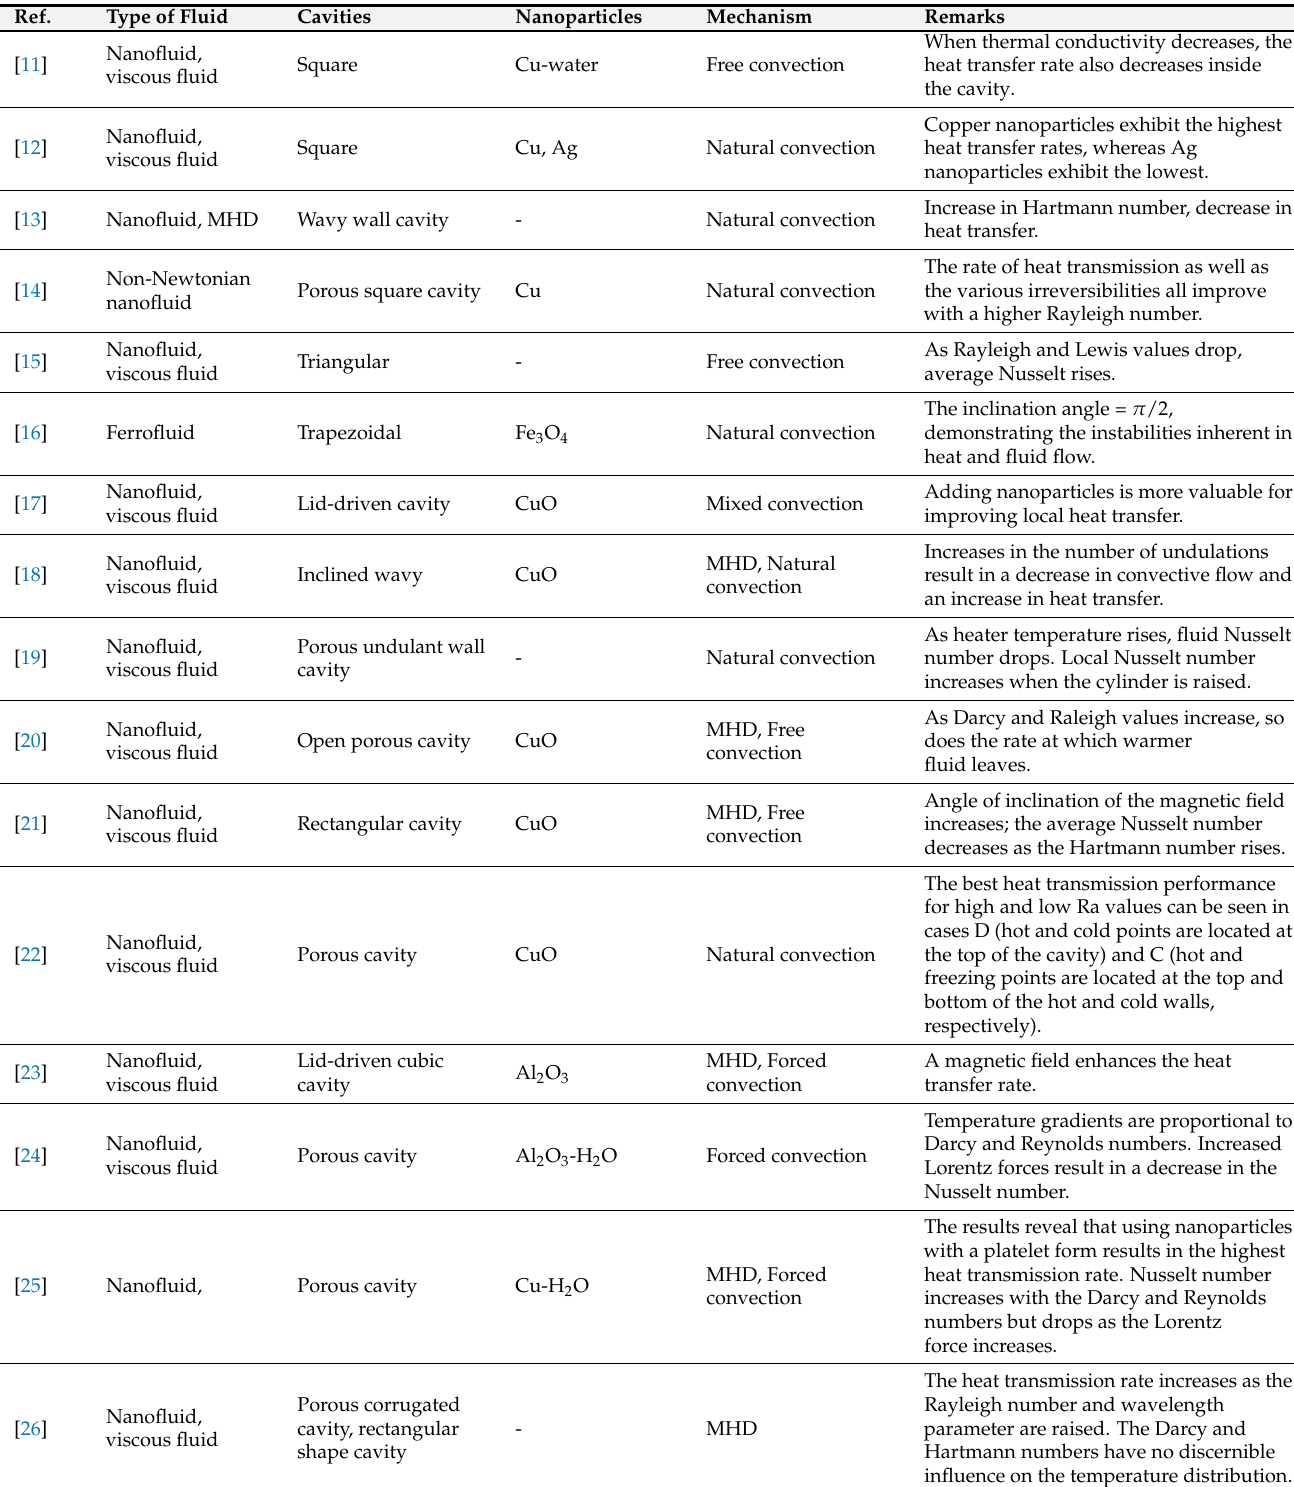
Table 1. Nanoparticles and cavities studies in convective heat